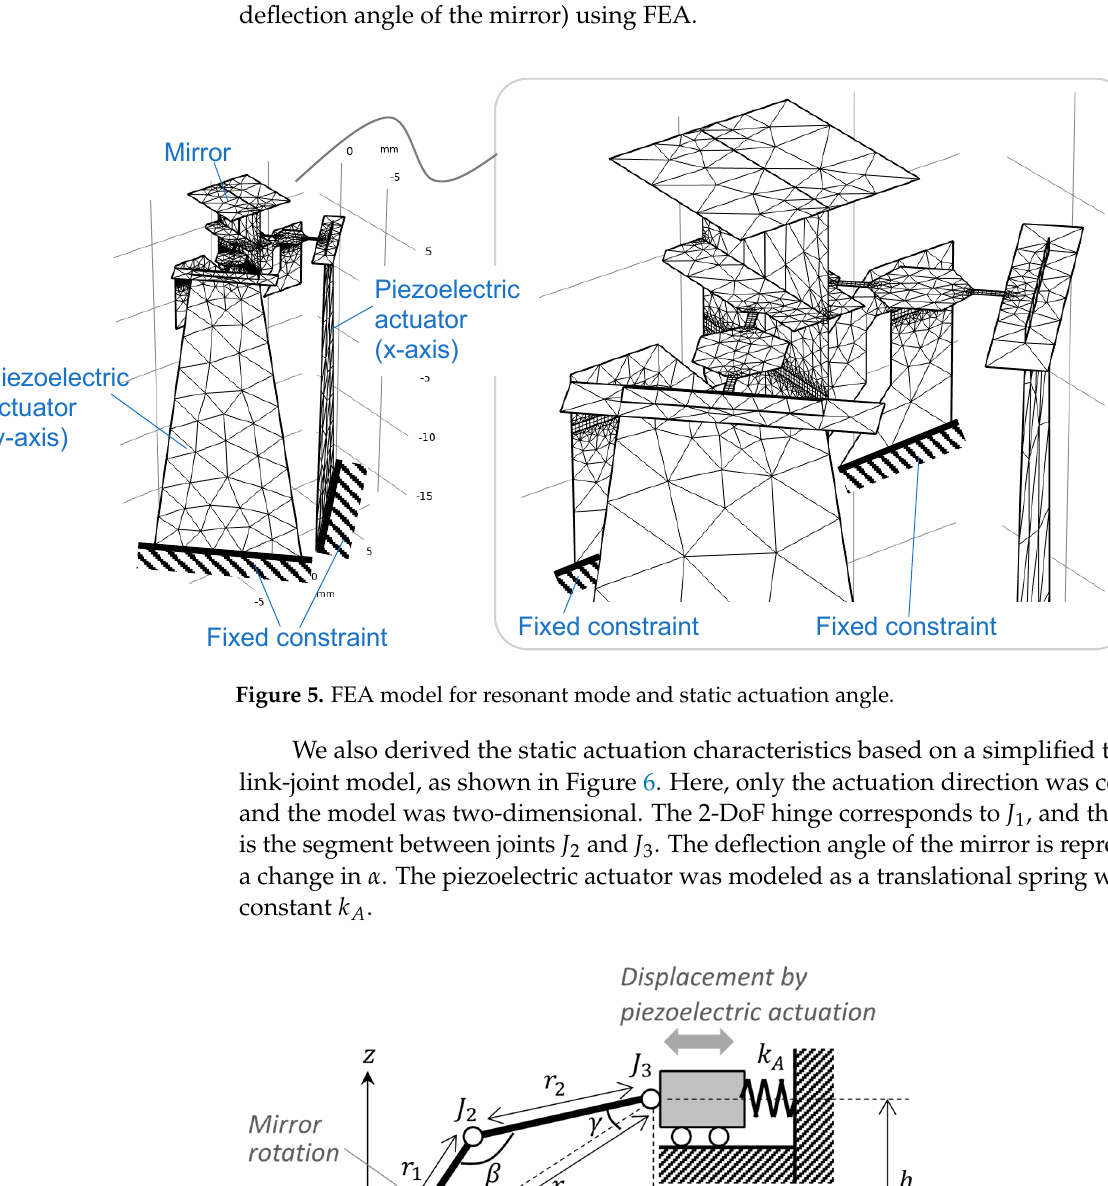
Figure 6. Simplified theoretical model to estimate static actuation angle.